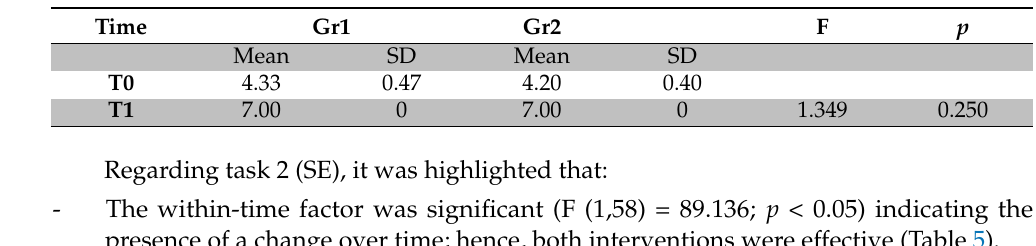
Table 4. Effect of time * group interaction on task 1 (PE).